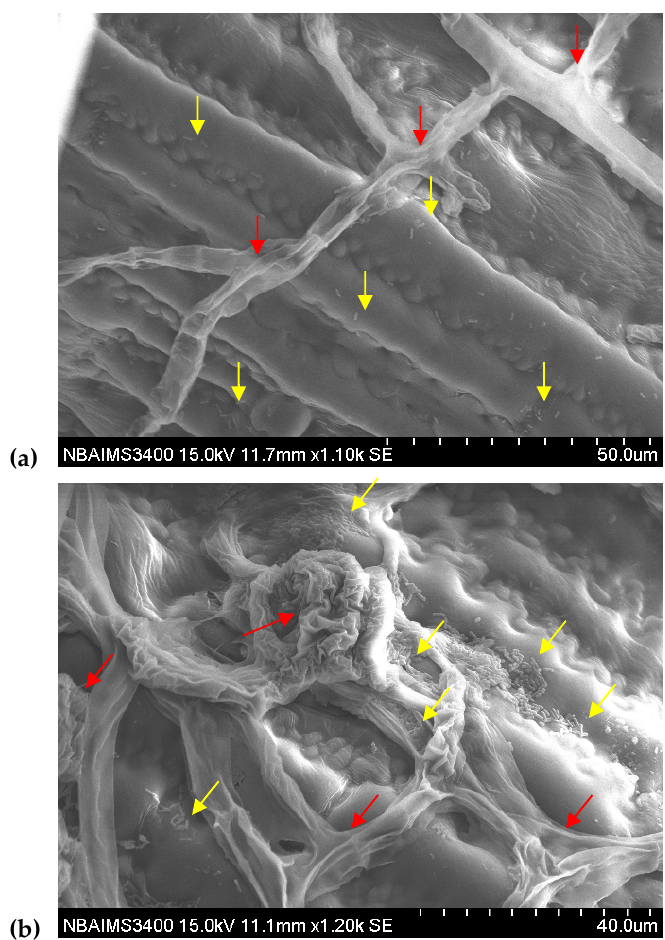
Figure 8. Scanning electron microscopic study showed the epiphytic colonization of GFP-tagged P. aeruginosa MF-30 on maize leaf. ( a ) microphotographs taken after 24 h of foliar application, ( b ) microphotographs taken at 7 days of foliar application. Red arrow indicated the fungal mycelia and infection cushion developed by R. solani on maize leaf, while yellow arrow showed the colonization of P. aeruginosa MF-30 on leaf surface, fungal mycelia, and infection cushion developed on maize leaf. Figure 8 ( b ) clearly indicates the lysis and disintegration of fungal mycelia and infection cushion caused by MF-30.